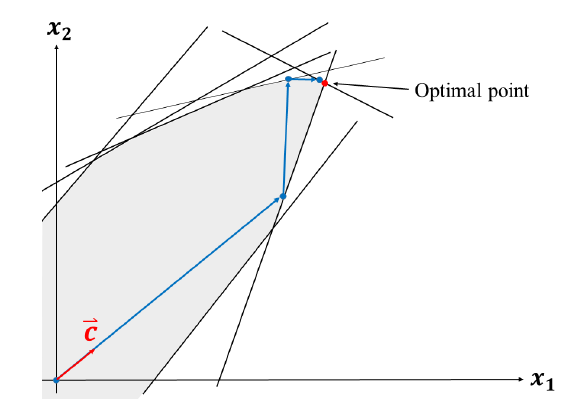
Figure 2. Iterative jumps from SAJS (self-regulating artificial-free linear programming solver using a jump and simplex